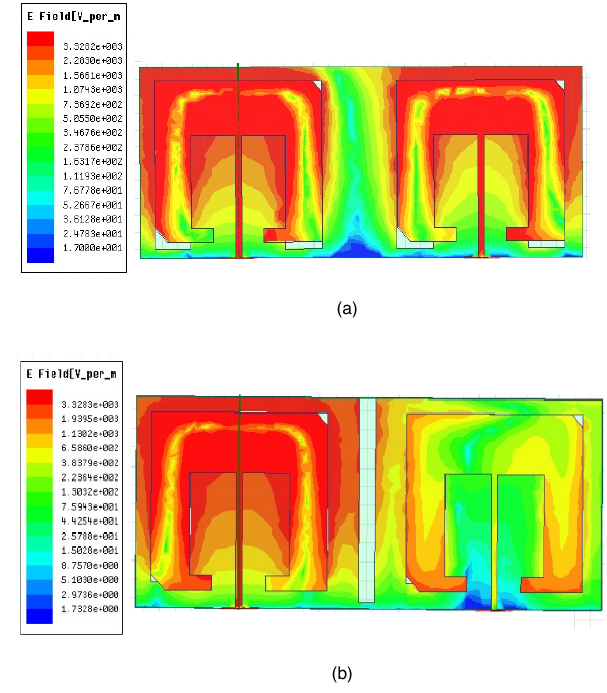
FIGURE 5. Fabric CP-MIMO antenna (a) without slit DGS (b) With Slit